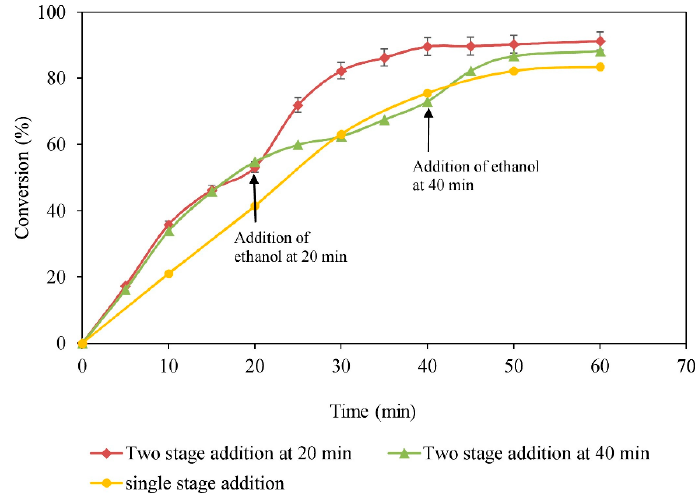
Figure 8. Dependence of lauric acid conversion on the EtOH-addition procedure [50].